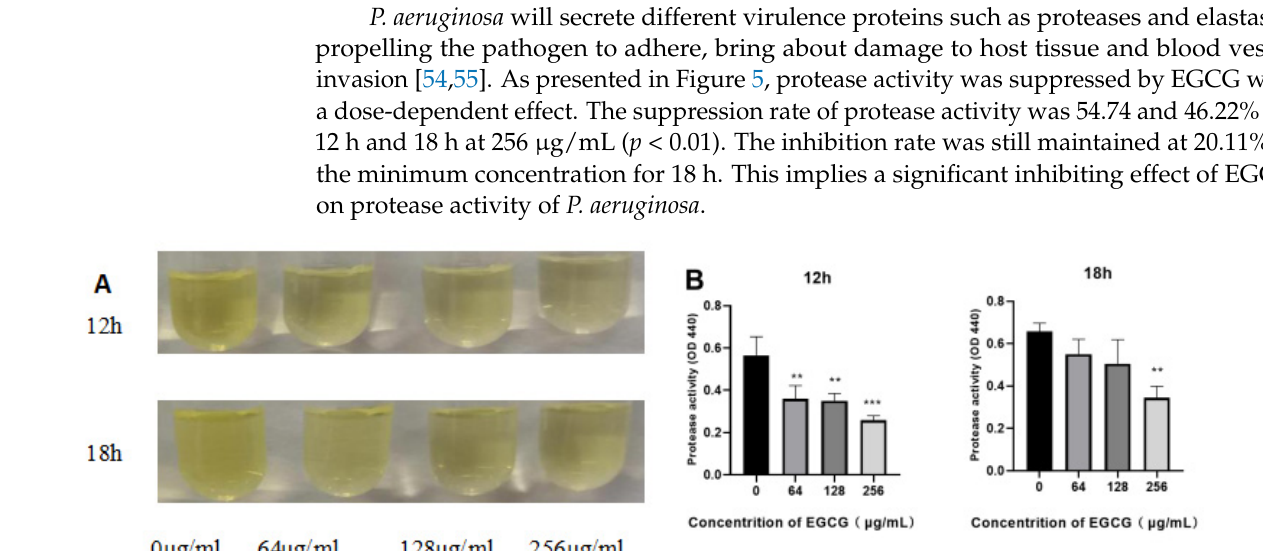
Figure 4. The inhibition of EGCG on P. aeruginosa pyocyanin production at 12 h, 18 h, and 24 h. (All data are representative of three independent experiments performed in triplicate and expressed as the mean ± SD values in each bar. * p < 0.05.